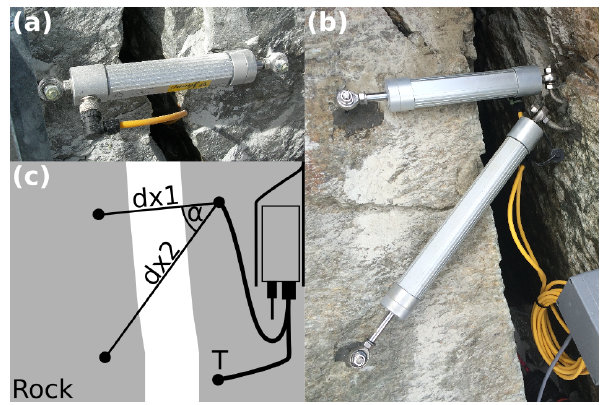
Figure 2. (a) One-axis and (b) two-axis crackmeter setup in the field. (c) Two-axis crackmeter setup with one thermistor connected to the wireless sensor network. In cases where multiple crackmeters are mounted on a single location the angle α between the two crack- meters is given in combination with the length of the